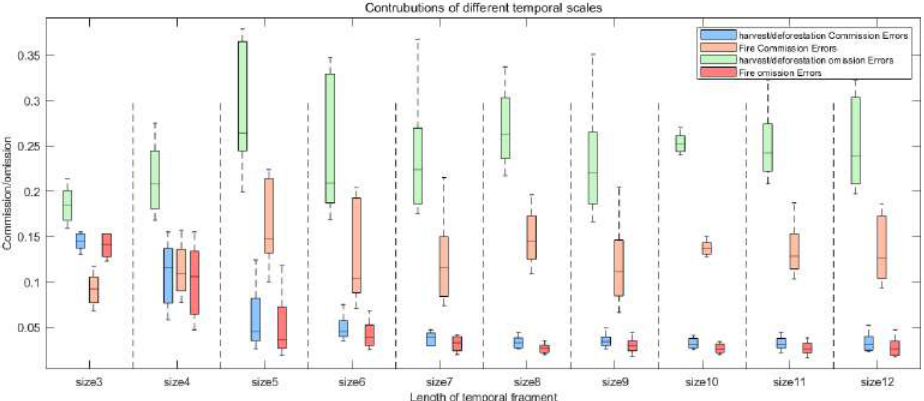
Figure 13. Overall accuracy regarding disturbance types with different lengths of temporal